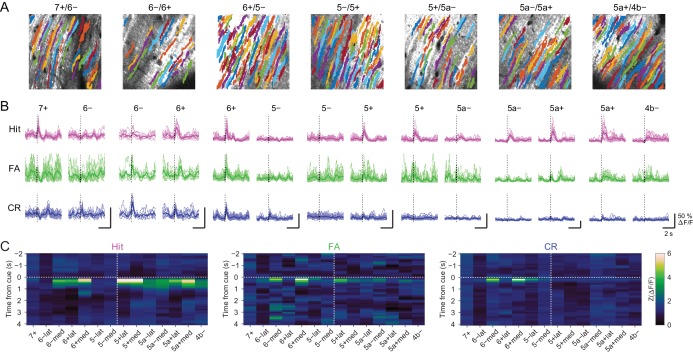
Mediolateral separation of task-related CF signals in the Crus II.(A) Extracted ROIs representing PC dendrites around the example 7+/6−, 6−/6+, 6+/5−, 5−/5+, 5+/5a−, 5a−/5a+, and 5a+/4b− boundaries that are pseudocolored and overlaid on the tdTomato image. Scale bars, 40 μm. (B) Single ROI trial-averaged traces for all the AldC compartments from the data in panel (A). Thick lines represent ROI-averaged traces. (C) Z-scored trial-averaged ΔF/F for each compartment averaged across sessions and mice, aligned from lateral to medial separately for AldC+ and AldC− compartments (n = 5, 3, 8, 9, 8, 3, and two mice, and 12, 4, 13, 15, 16, 13 and 6 sessions for 7+/6−, 6−/6+, 6+/5−, 5−/5+, 5+/5a−, 5a−/5a+ and 5a+/4b− boundaries, respectively). Vertical dashed lines delineate the lateral and medial Crus II. Horizontal dashed lines represent cue onset.10.7554/eLife.47021.018Figure 3—figure supplement 1—source data 1.Datasets used to create Figure 3—figure supplement 1.